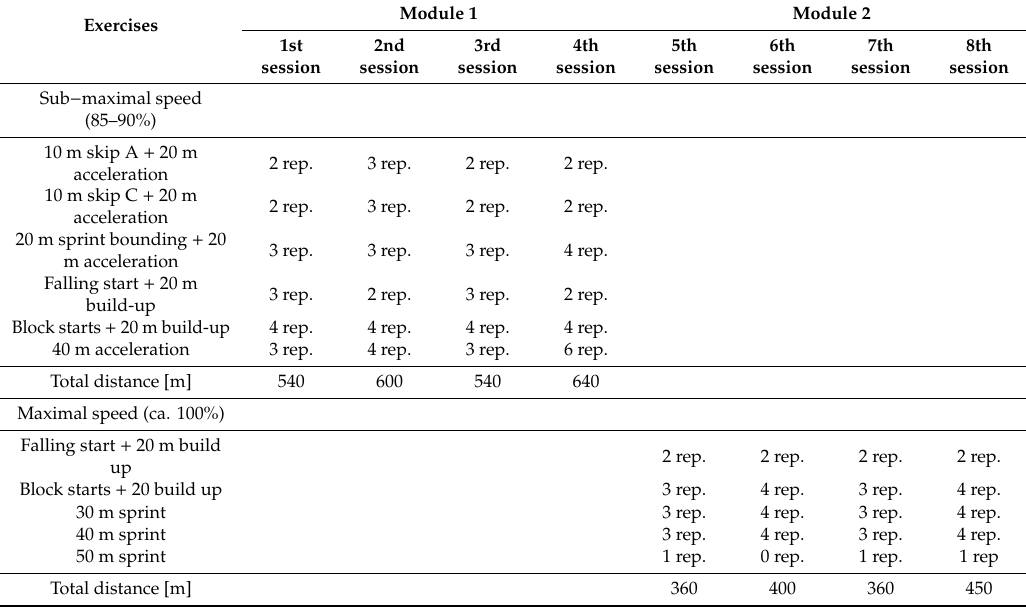
Table 2. Speed training (ST)